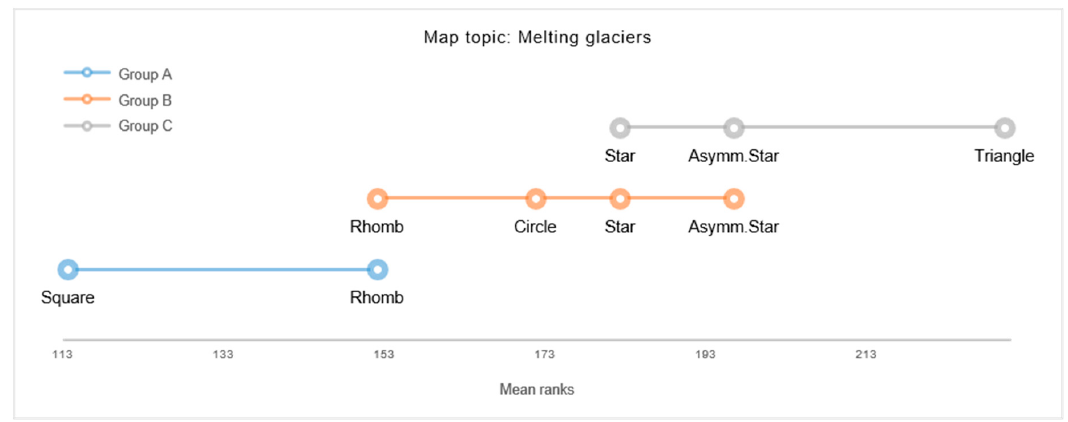
Figure 14. Map #10: Results of multiple pairwise comparisons, indicating groups of (dis)similar symbol-content